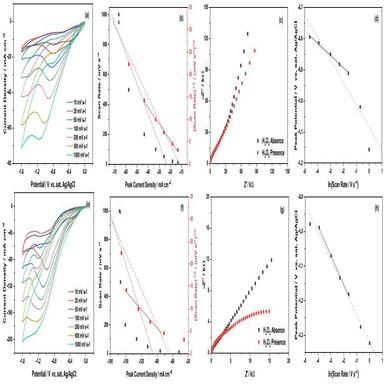
Cyclic voltammetry test of hydrogen peroxide on electrode. (a) CV curve of H2O2 on GCE at different scan rate; (b) the linear relationship between cathodic peak current density with scan rate and square root of scan rate on GCE; (c) EIS of H2O2 detected on GCE; (d) the linear relationship between cathodic peak potential and logarithm of scan rate on GCE; (e) CV curve of H2O2 on BC-GCE at different scan rate; (f) the linear relationship between cathodic peak current density with scan rate and square root of